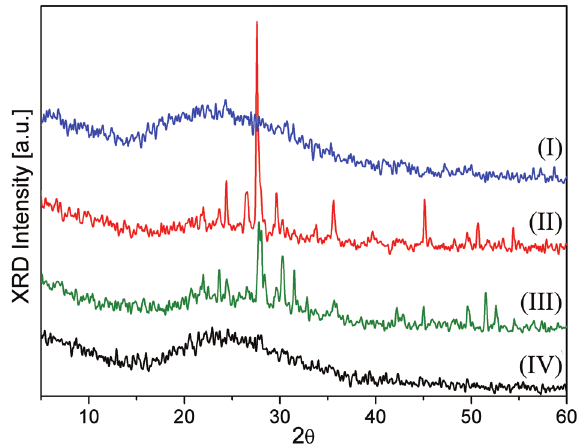
Figure 1: Comparative XRD patterns for catalysts based on volcanic ash materials: (I) PVA 40, (II) PVA 40-60, (III) PVA 60-100, and (IV) PVA